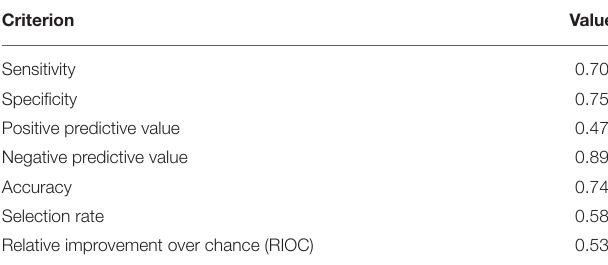
TABLE 4 | Quality criteria of index-finger pointing at 12 months as screening tool for LD at 24